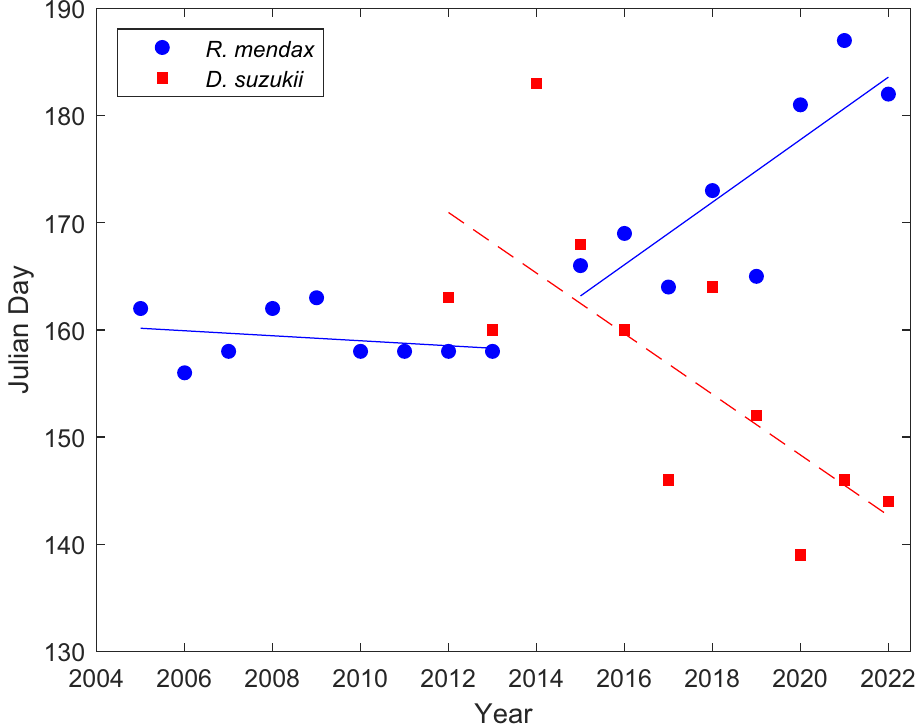
Fig 2. Annual first capture dates in Julian days of Rhagoletis mendax and Drosophila suzukii . Blue circles represent observed R . mendax capture date, red squares represent observed D . suzukii capture date, the solid blue line is a linear fit of the R . mendax first capture dates for the period of 2005 to 2013 and 2015 to 2022, and the dashed red line is a linear fit of the D . suzukii from 2012 to 2022. The correlation coefficient ( r ) between annual R . mendax captures and annual Drosophila suzukii captures of the prior year is r = − 0.84 with a P = 0.019 indicating significant correlation.